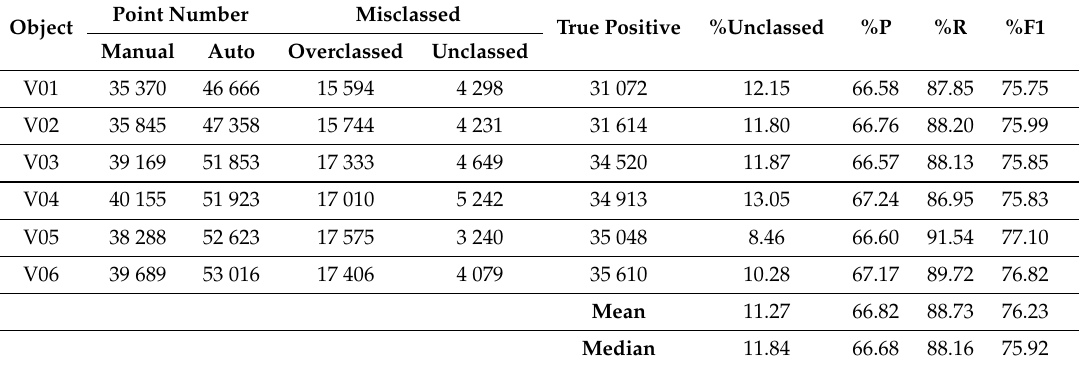
Table 6. Quantitative analysis on the results of step 2 for the detection and classification of columns in the Valentino dataset. Note that only the detected columns were taken into account here. %P is precision, %R is recall, and %F1 is the normalized F1